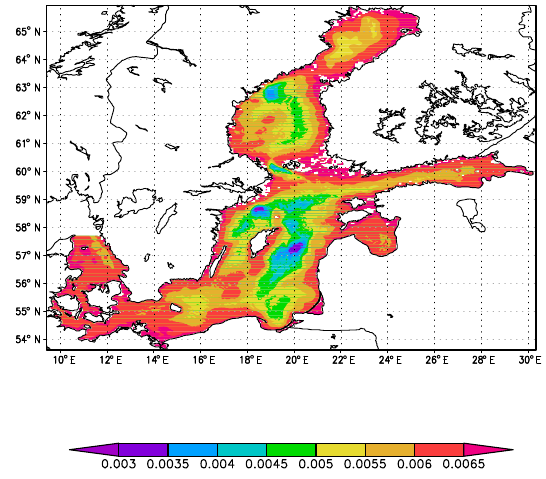
Figure 1. The gradient of the functional G(T ) (m − 2 s − 1 ).